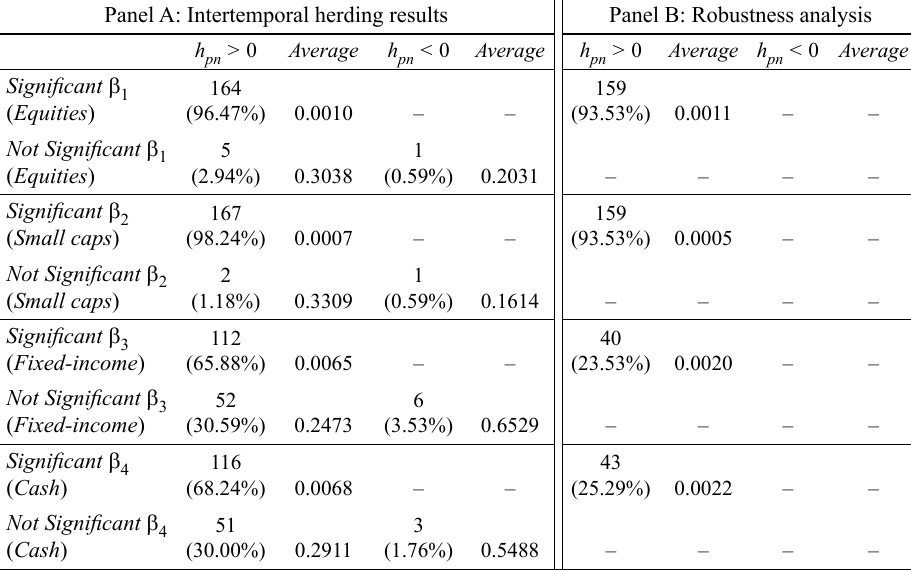
Table 7. Intertemporal herding